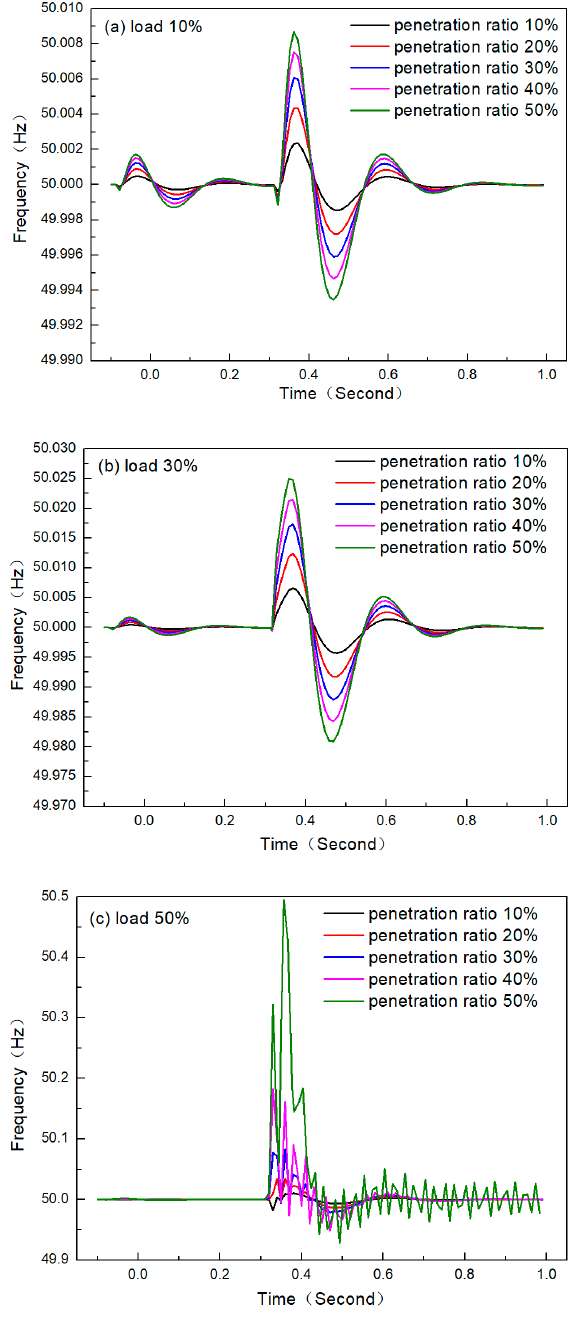
Figure 8. Influence of PV penetration rate and load change on grid frequency at nodes e: ( a ) load 10%; ( b ) load 30%; ( c ) load 50%.